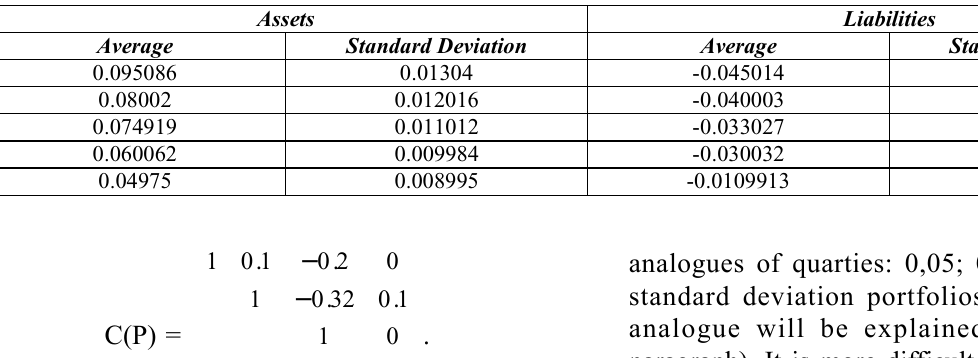
Table 1 . Assets and Liabilities profitability probability